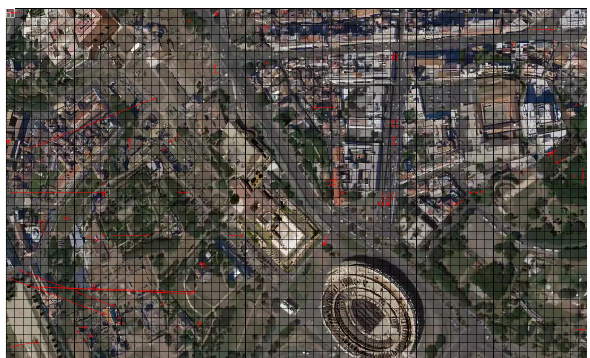
Figure 2: An example of failure of the motion estimation at low frame rates (0.5